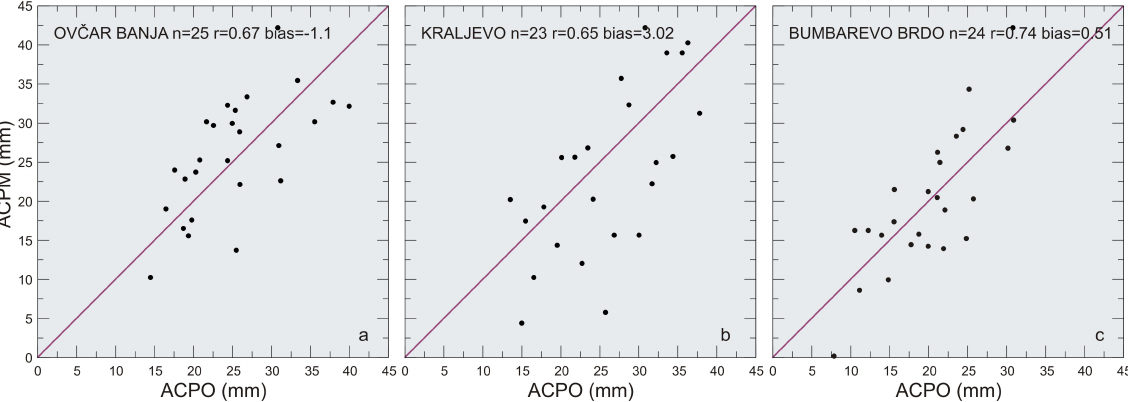
Fig. 6. Scatter diagrams of model accumulated convective precipitation, ACPM (mm), vs their observed counterparts, ACPO (mm), for rain gauge stations (a) Ovˇcar Banja, (b) Kraljevo and (c) Bumbarevo